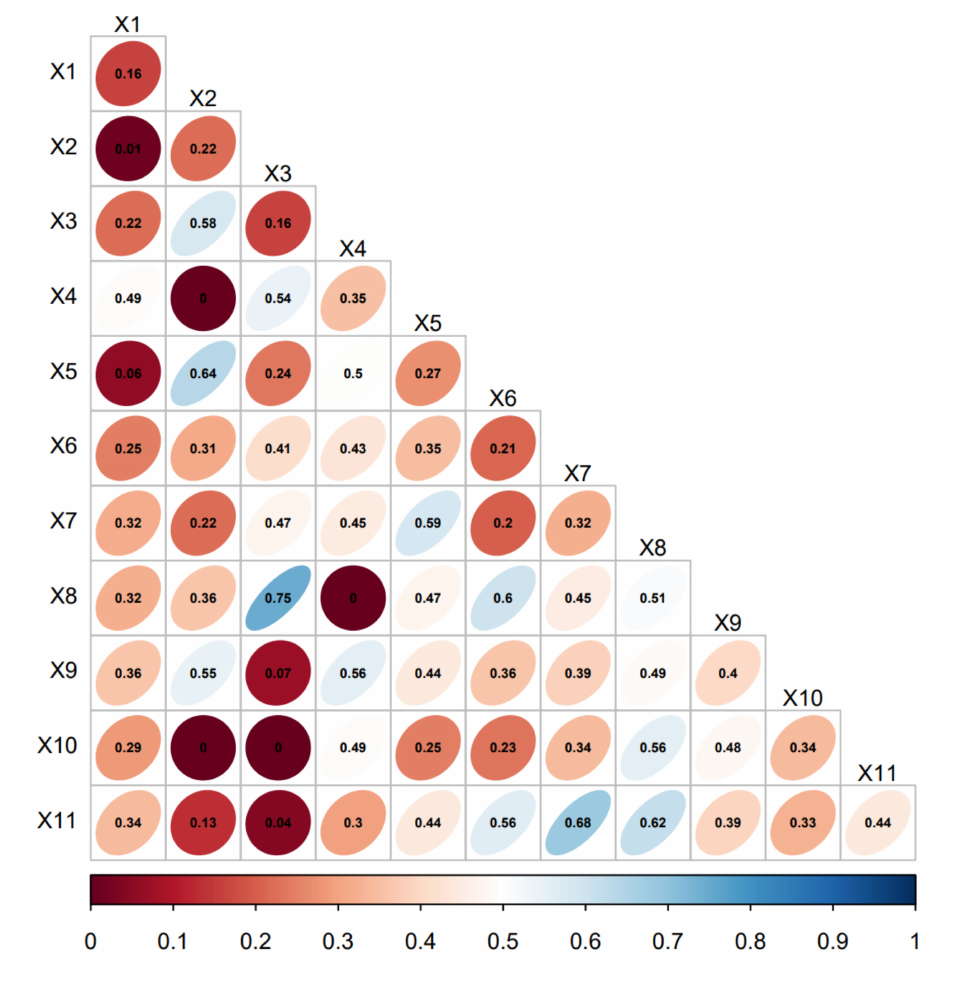
Figure 5. Factor interaction